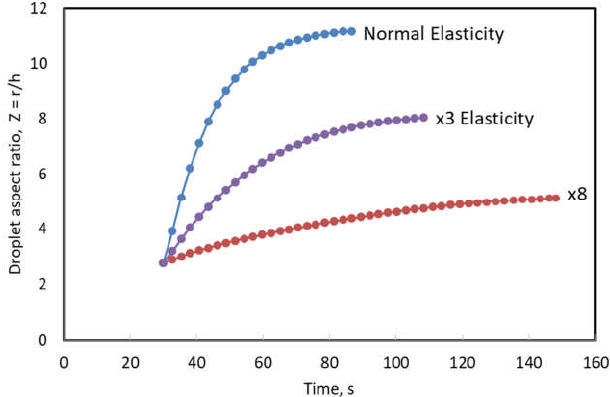
Figure 7. Effect of elasticity on droplet spreading. t ext = 30 s ( V = 2 cm 3 , γ = 45 mN/m).